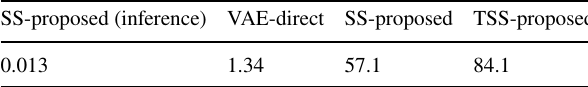
Table 3 Computation time (s) on MNIST-r